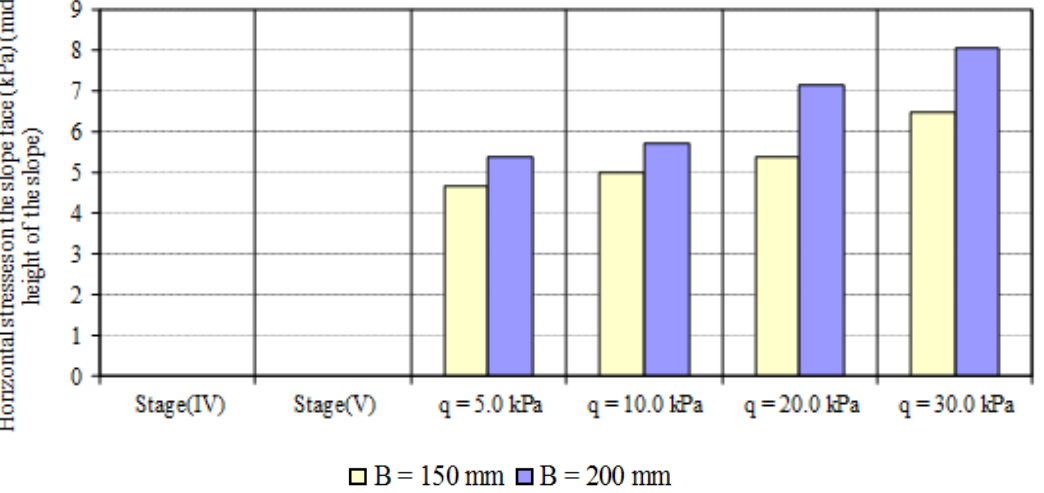
Figure 22. Influence of footing width on the slope face horizontal stresses at mid-height of slope.